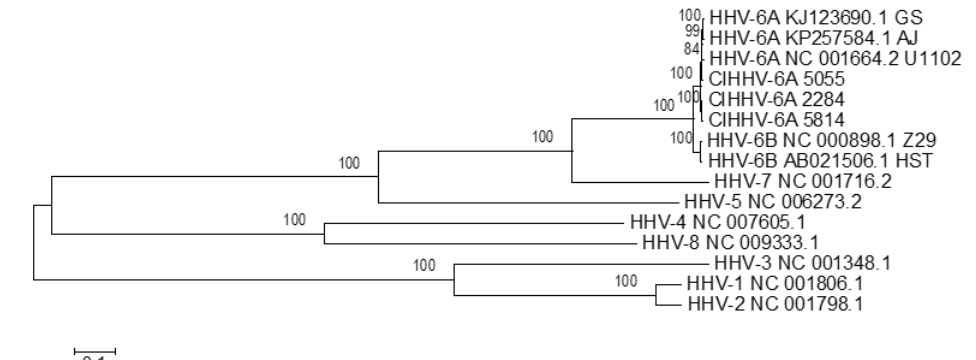
Figure 1. Phylogenetic analyses of CiHHV-6A compared to human herpesvirus representative of herpesviridae species in alpha, beta, and gamma herpesvirus sub-families. Maximum likelihood method was used in Mega 5.1 using core conserved genes to compare the relationship of CiHHV-6A 5055, 2284, and 5814 genomes to betaherpesviruses including the Roseolovirus genera of HHV-6A, HHV-6B, HHV-7, together with Human cytomegalovirus (HHV-5); gammaherpesviruses Epstein Barr virus (HHV-4) and Kaposi’s sarcoma associated herpesvirus (HHV-8); alphaherpesviruses Herpes Simplex Virus (HSV) type 1, HSV-1 (HHV-1), and HSV-2 (HHV-2). The reference sequences accession numbers used are shown in the figure. Core genes included homologues of capsid triplex subunit 1 (U29), small capsid protein (U32), large tegument protein (U3), large tegument binding protein (U30), cytoplasmic egress tegument protein (U71), cytoplasmic egress facilitator-1b (U44), glycoproteins gB, gL, gM (U39, U82, U72), multifunctional expression regulator (U42), DNA polymerase catalytic subunit (U38), DNA polymerase processivity subunit (U27), helicase-primase RNA polymerase subunit (U43), helicase primase subunit (U74), single-stranded DNA-binding protein (U41), alkaline deoxyribonuclease (U0), uracil DNA glycolase (U81), ribonucleotide reductase large subunit (U28), capsid transport nuclear protein (U36), DNA packaging terminase subunit 2 (U40), terminase binding protein (U35), nuclear egress membrane protein (U34), and nuclear egress lamina protein (U37). Bootstrapping (1000) shows percentage of trees where taxa cluster together and scale shows branch lengths measured in number of substitutions per